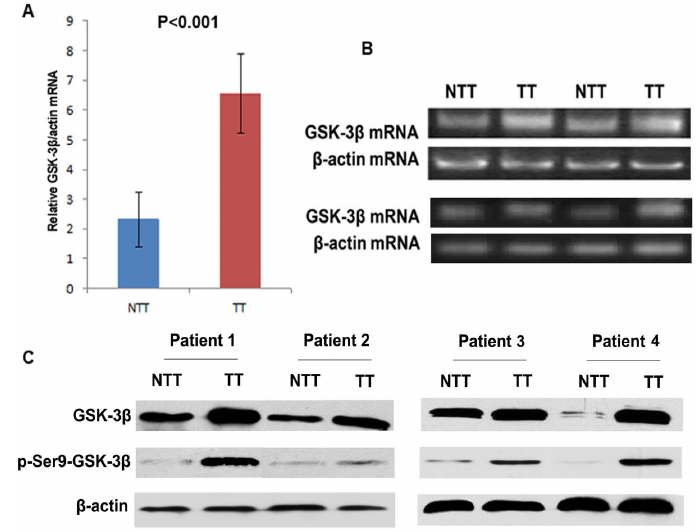
Figure 1. Expression of GSK-3 b and p-Ser9-GSK-3 b in HCC. (A) Relative expression level of GSK-3 b mRNA in 60 tumor tissues(TT) and paired non-tumorous tissues(NTT) by RT-PCR (P , 0.001). (B) RT-PCR analysis of GSK-3 b mRNA expression. (C) Expressions of p-Ser9-GSK-3 b were analyzed by Western Blotting in HCC tumor tissues(TT) and paired non-tumorous tissues(NTT).